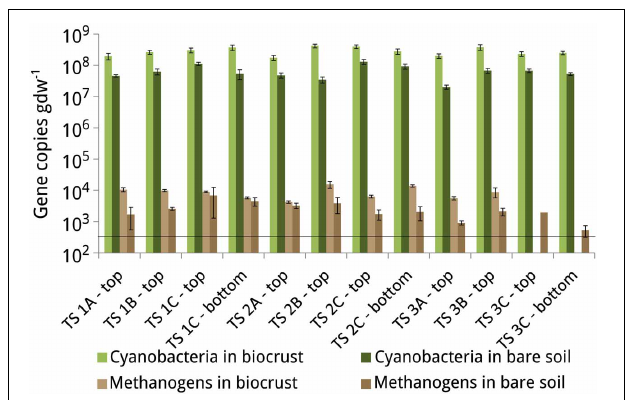
FIGURE 5 | Gene copy numbers of the 16S rRNA gene of cyanobacteria and the mcrA gene of methanogens in the biocrusts and bare soils of the lateral moraines in Tsomoriri Plains. Horizontal line: detection limit (5 × 10 2 gene copies gdw − 1 ). Means ± SE of n = 6 (2 independent qPCR reactions containing 3 replicates of the PCR